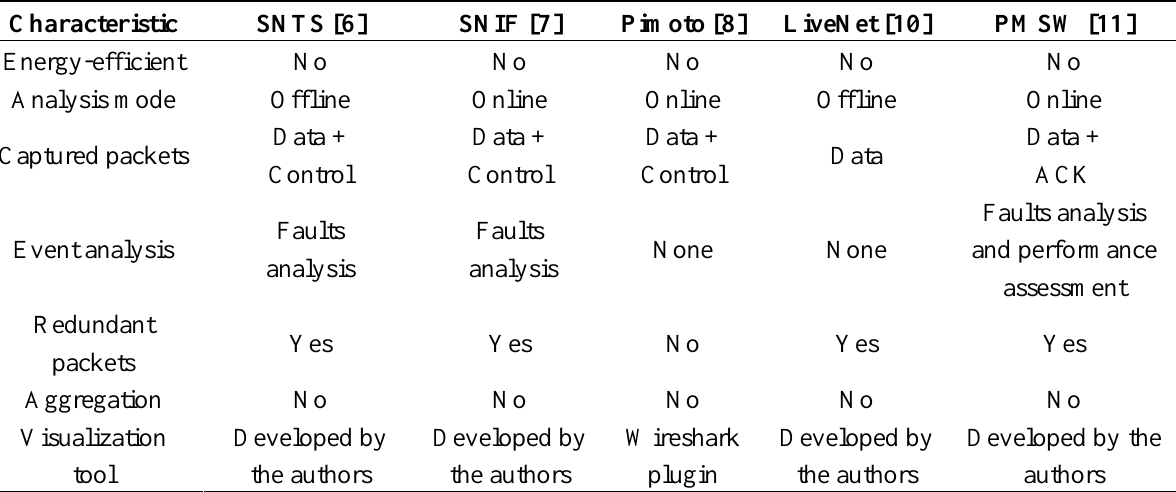
Table 1. Characteristics of monitoring